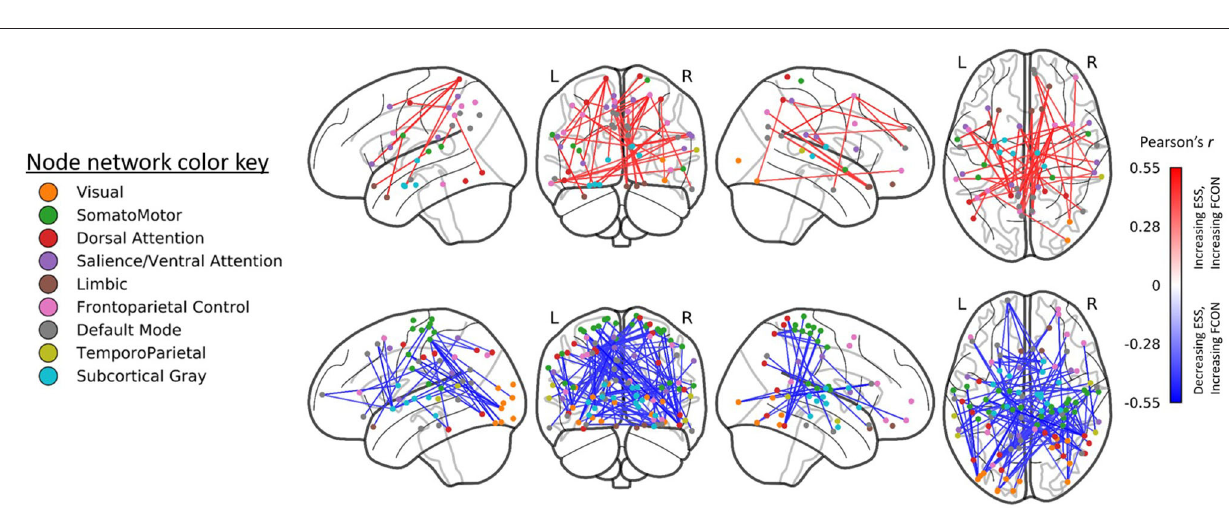
FIGURE 4 | Edges (region-to-region connections) exhibiting moderate-to-large correlations (| r | > 0.4) between Epworth Sleepiness Scale scores and gray matter volume (GMV) at post-treatment (right). Treatment-related decreases in daytime sleepiness were associated with moderate-to-large increases in functional connectivity in 82 edges and with decreases in functional connectivity in 39 edges. All edgewise correlations were FDR corrected at p <